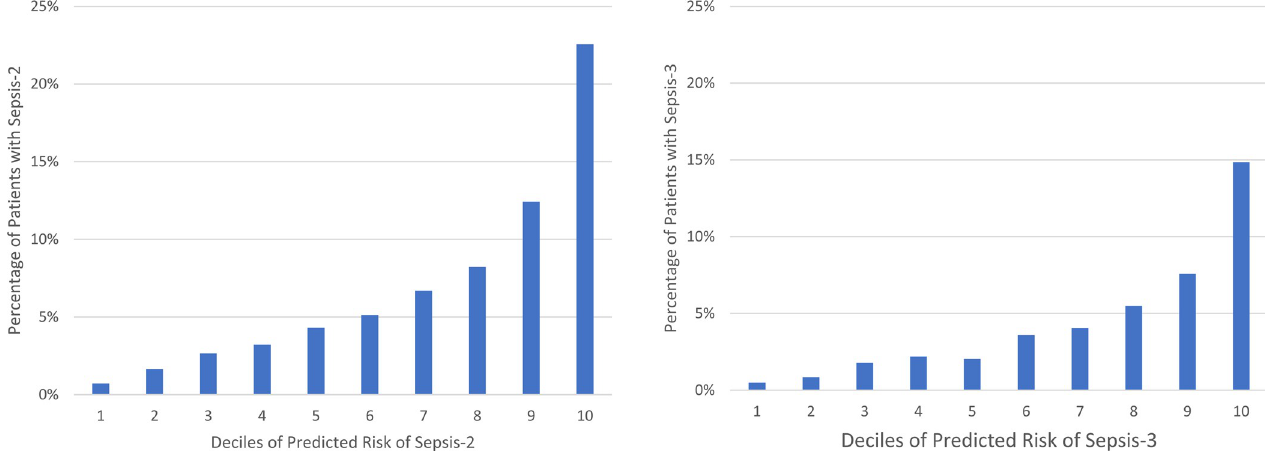
Fig 5. Calibration plot showing the fraction of patients with sepsis for each decile of risk calculated from the polygenic risk score. Sepsis-2 (left), Sepsis-3 (right).